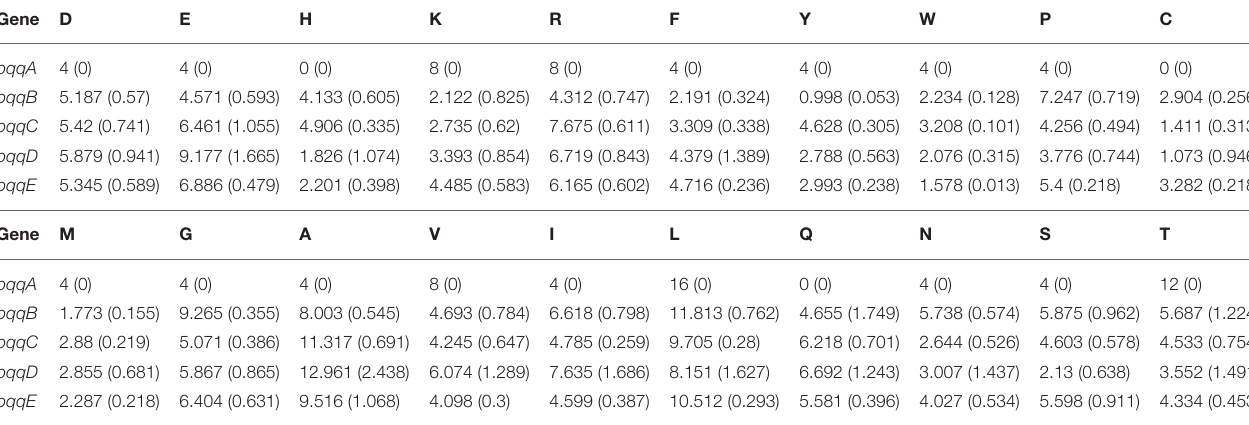
TABLE 5 | Average and standard deviation of amino acid frequencies of the PQQ pathway-associated genes from selected Gammaproteobacteria. Gene D